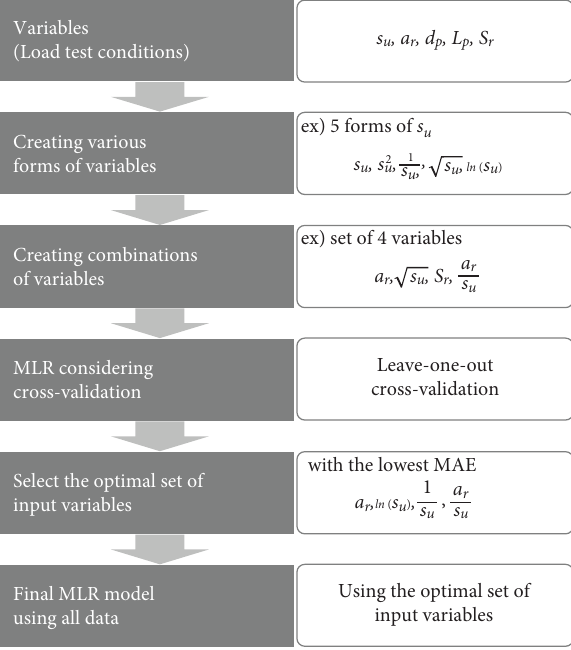
Figure 3: Diagram of MLR modeling process.